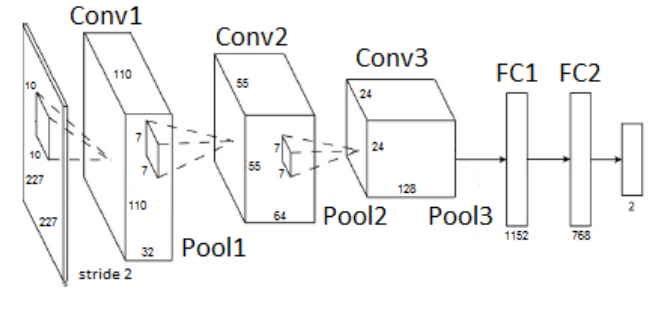
Figure 8. CNN1 architecture. Table 1. CNN1 architecture